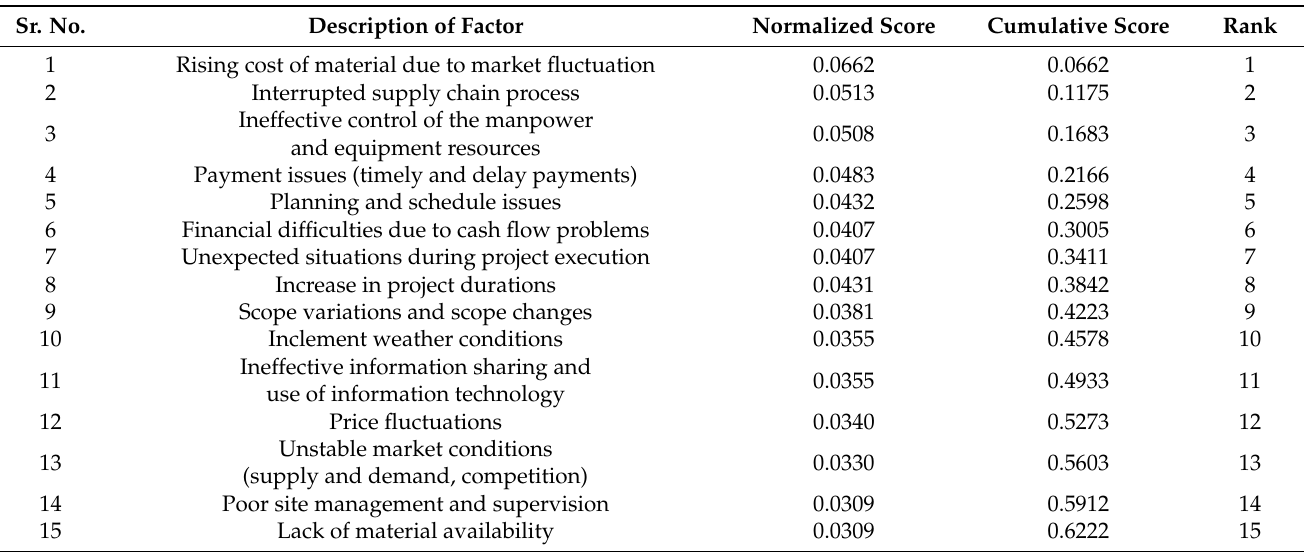
Table 3. Significant profitability-influencing factors risk